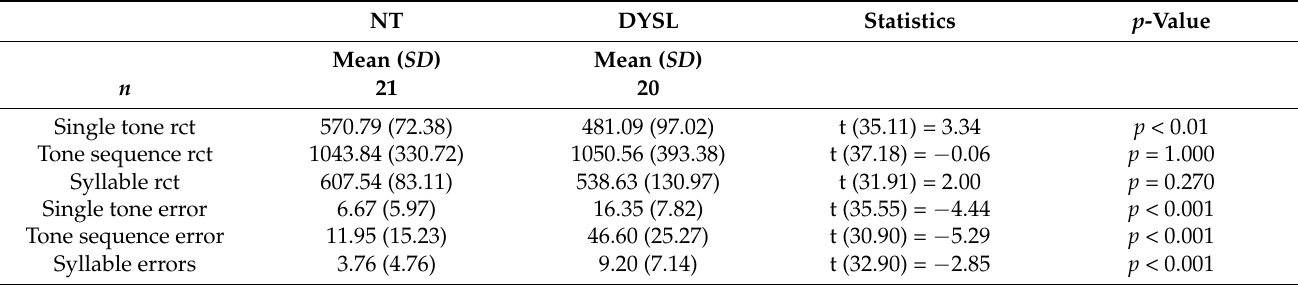
Table 5. Auditory